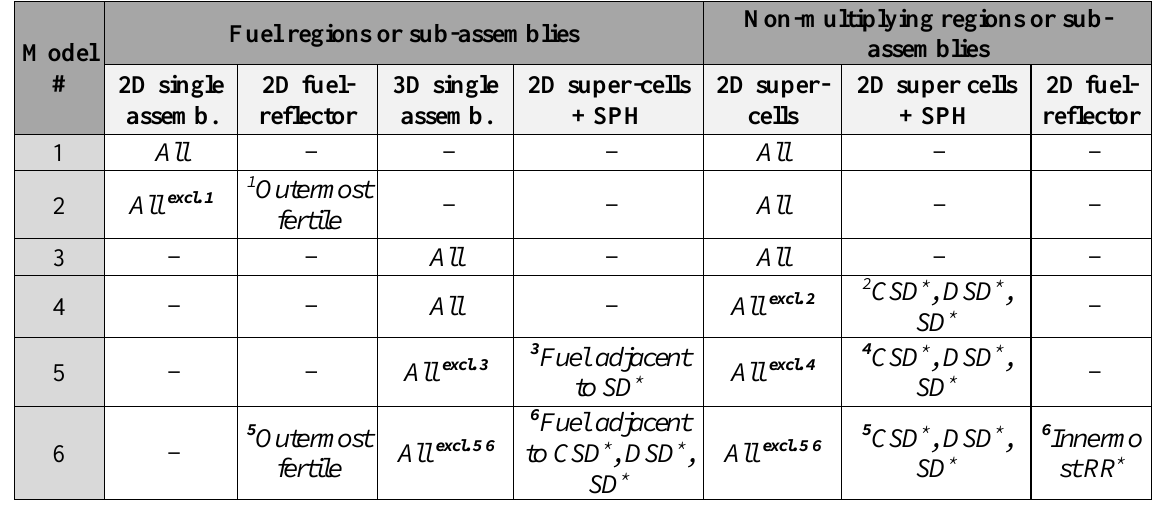
Table I. XS generation and correction methods for various core